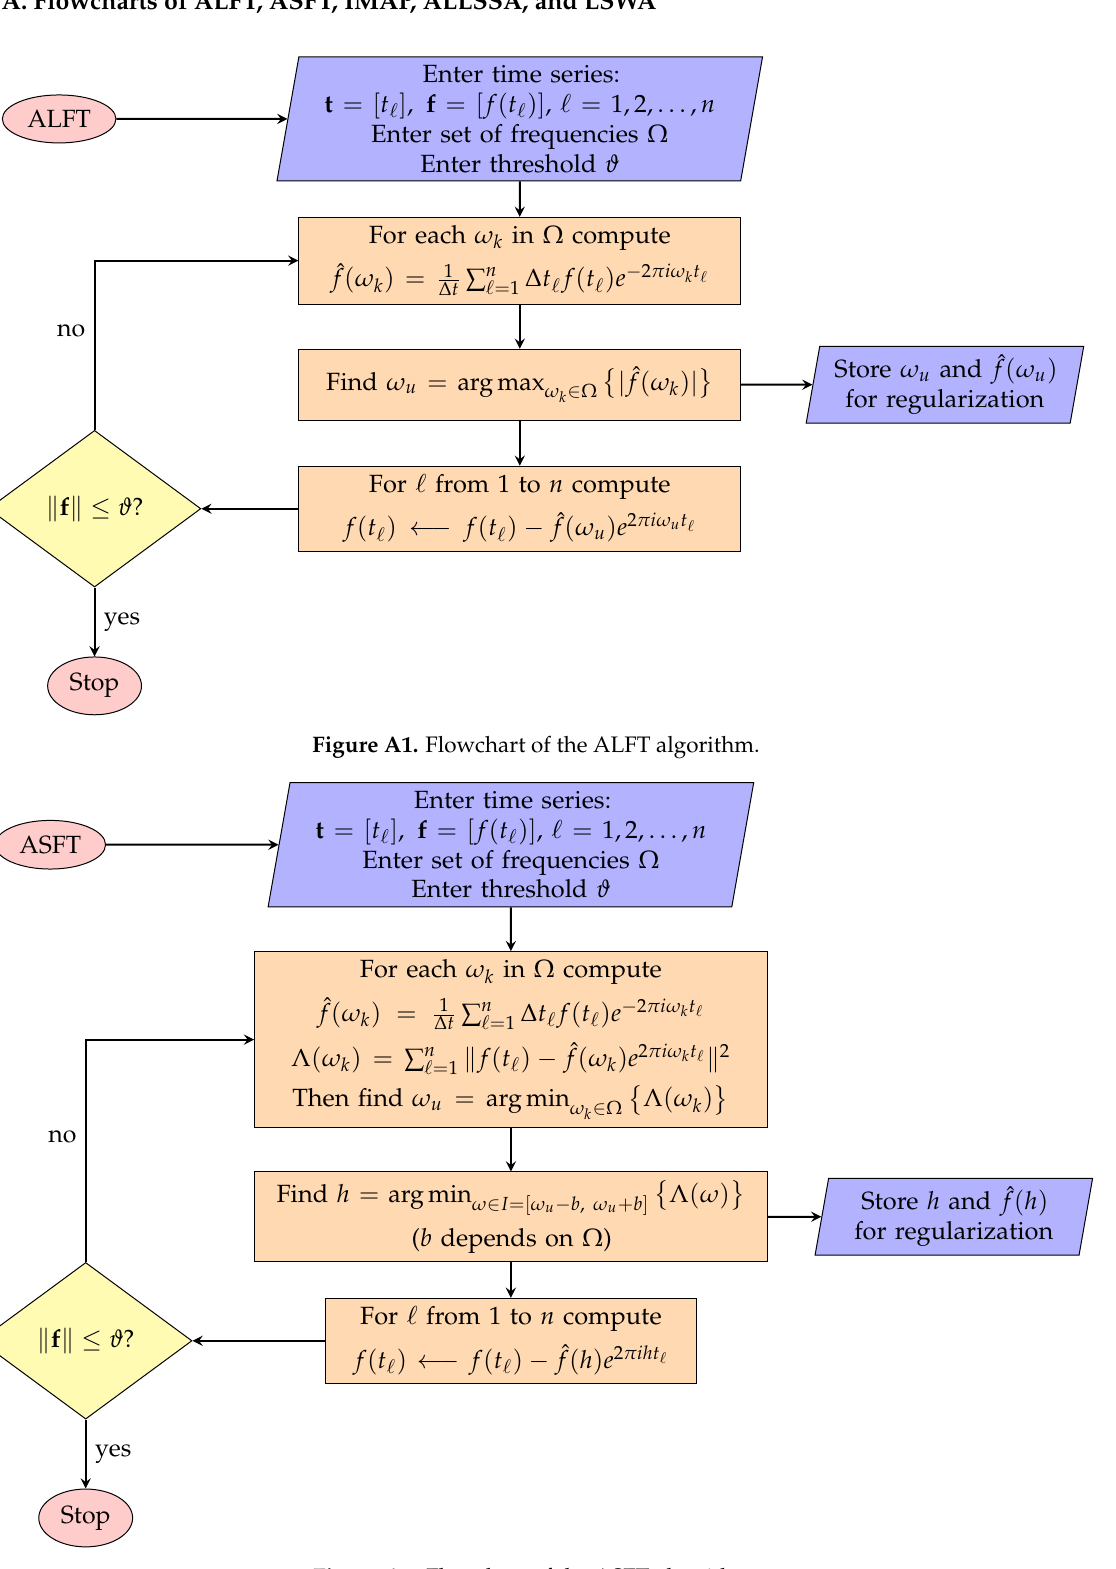
Figure A2. Flowchart of the ASFT